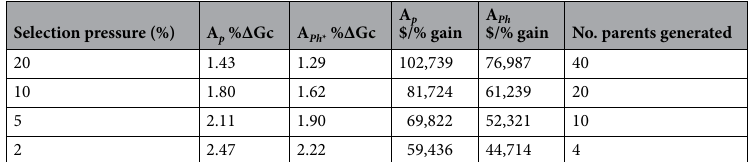
Table 2. Simulated predictions of percentage genetic gain per cycle (3 years) of selection (%ΔGc), at different selection pressure (%), for perennial ryegrass dry matter (DM) yield and associated cost per percentage genetic gain ($ per % gain), from half-sib (HS) family phenotypic selection among 200 families evaluated across 2 years, 3 seasons and 2 locations. A p , DM yield data collected using seasonal herbage cuts; A Ph , DM yield data generated using seasonal phenomics based phenotyping. The costs associated with achieving one percent genetic gain based on DM cuts and phenomics were $7.50 and $0.87 per sample, respectively. The associated number of selected parents are indicated. A cycle of selection is the sum of the number of years of the field trial (2 years) plus one extra year for progeny generation, total 3 years. $, New Zealand dollars. These results are based on the estimated variance components, from REML analysis of the mock data, used as starting points for simulation of breeding methods. Ph *, LiDAR based phenomics accuracy = 0.90.